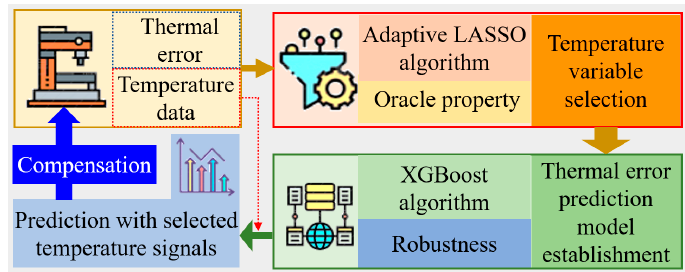
Figure 5. Flowchart of the proposed ALIX methodology.